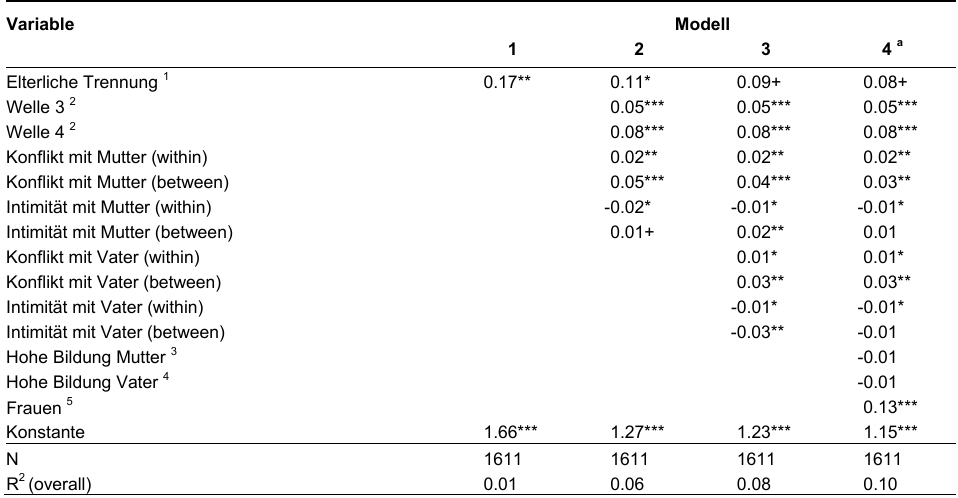
Tabelle 2 : Regression elterlicher Trennung auf Depressivität